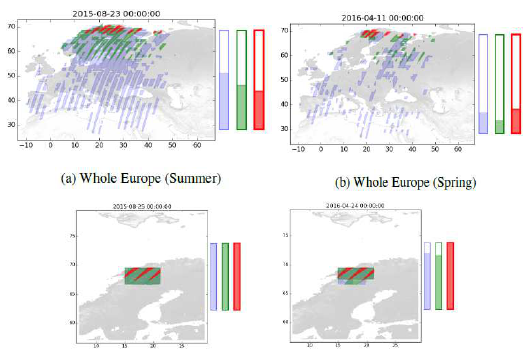
Figure 21. Area that can actually be produced given current archive for two dates (one in summer and one in spring), with a time frame of one month and cloud cover less than 10 %, over the whole GRI area, and the Sweden test site. Blue areas represent overlap between adjacent orbits, while green (resp. red) areas represent overlap between 1 orbit (resp. 2